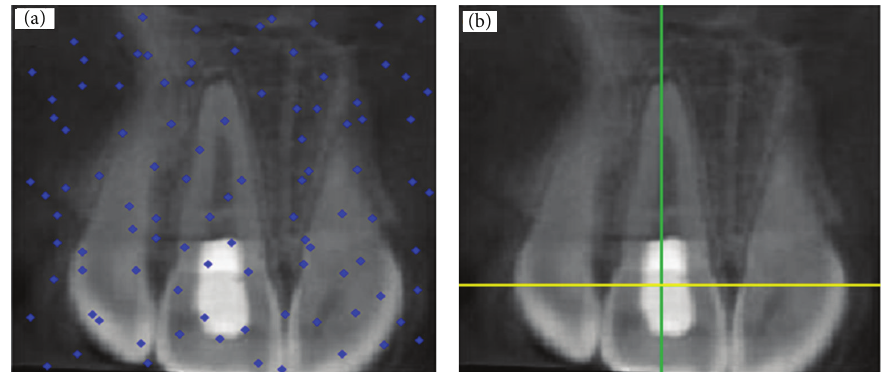
Figure 7: (a) Distribution of particles for detection of dental caries and restoration (b) and detection of one tooth with restoration, depicted by green line crossed with yellow line.